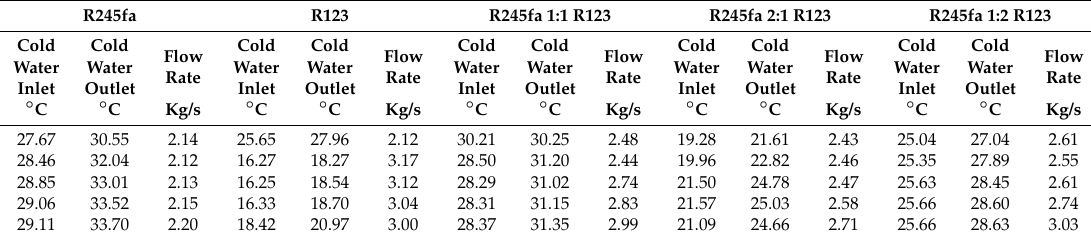
Table 5. Data condition of cooling cycle